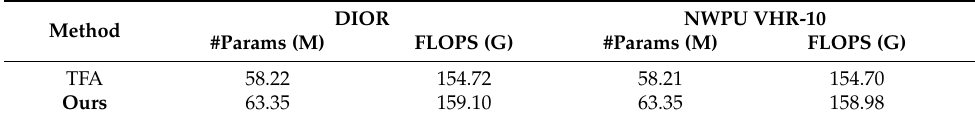
Table 8. Model parameters and computational